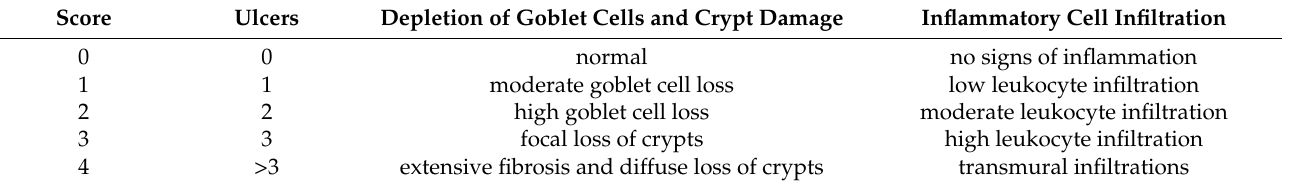
Table 2. Histological